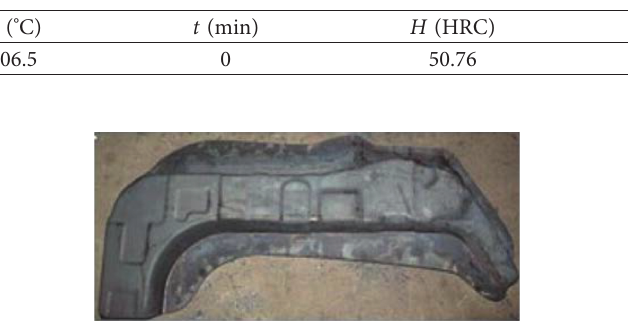
Figure 11: A-pillar after multiobjective optimization.